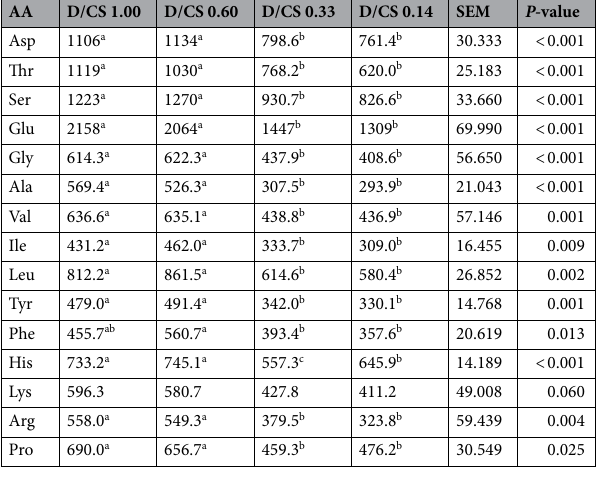
Table 4. The basic IEAAs losses (mg/kg DM intake) in ileum of broiler chickens. Values are expressed as the mean and pooled SEM (n = 6 per group). Different superscript letters in the same row mean significant differences ( P < 0.05).